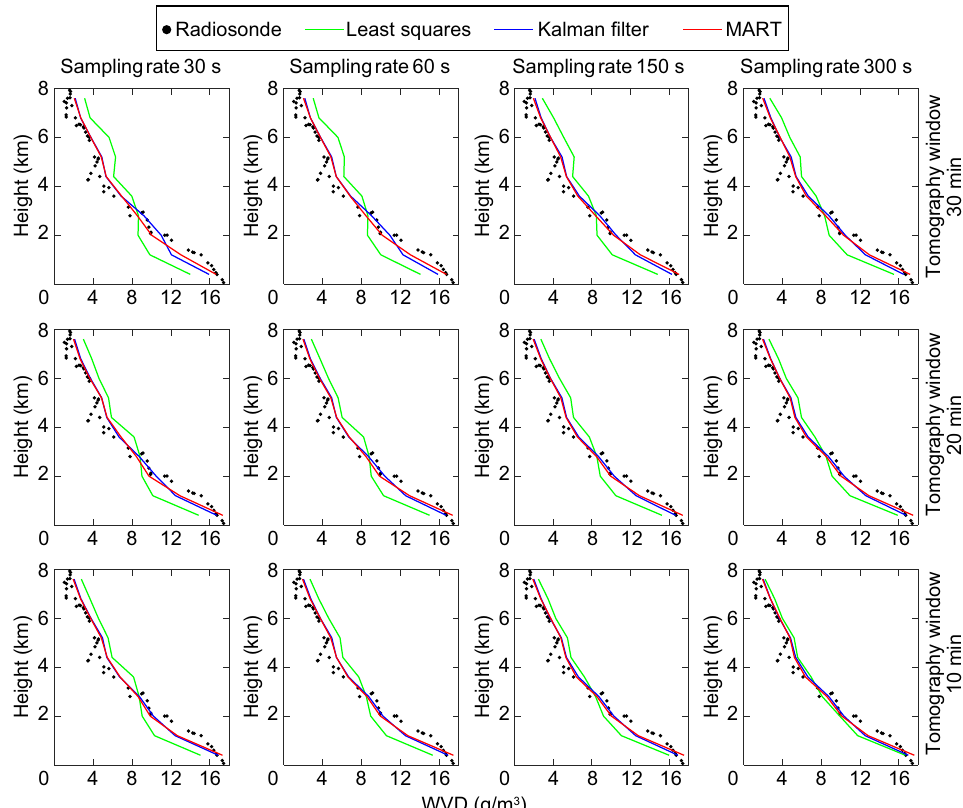
Fig. 6 water vapor density comparison between radiosonde data and the three tomographic methods in different schemes